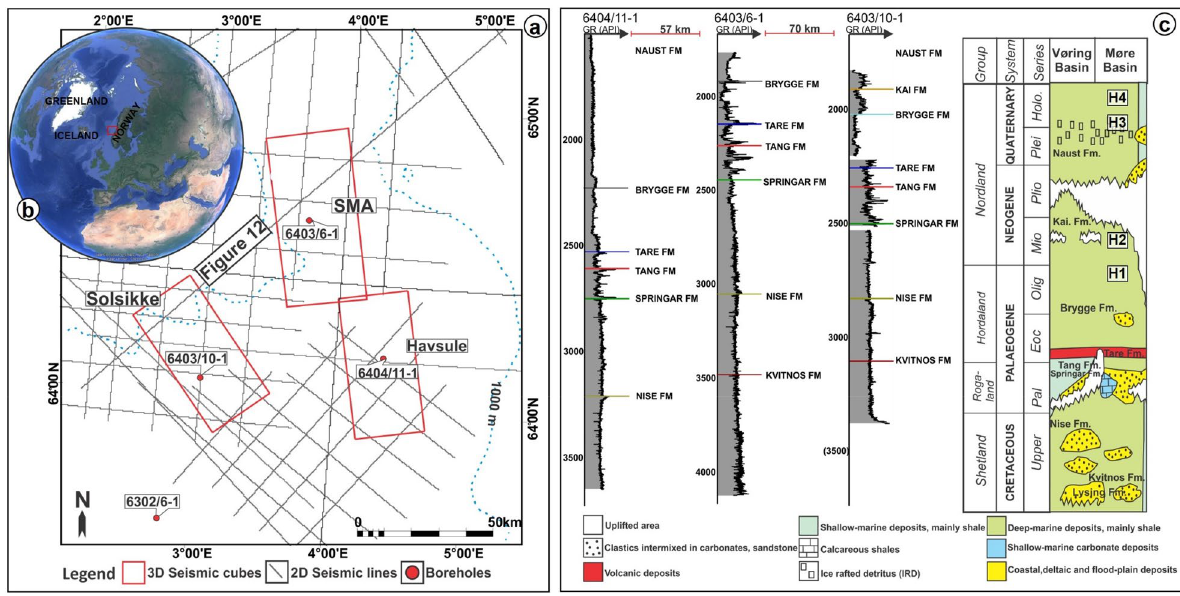
Figure 1. ( a ) Map showing the location of the 3 three-dimensional (3-D) and two-dimensional (2-D) seismic reflection data, plus the well data used in this study ( b ) Inset shows the location of the study area in the context of the Norwegian continental margin. The red box outlines the study area. ( c ) Well correlation panel between wells 6404/11-1, 6403/6-1, and 6403/10-1 and a simplified stratigraphic column for the study area. This study focuses on the stratigraphic interval spanning from the Brygge to the Naust formations. Included in the column are the main representative lithologies and the regional lithostratigraphy of the Vøring and Møre